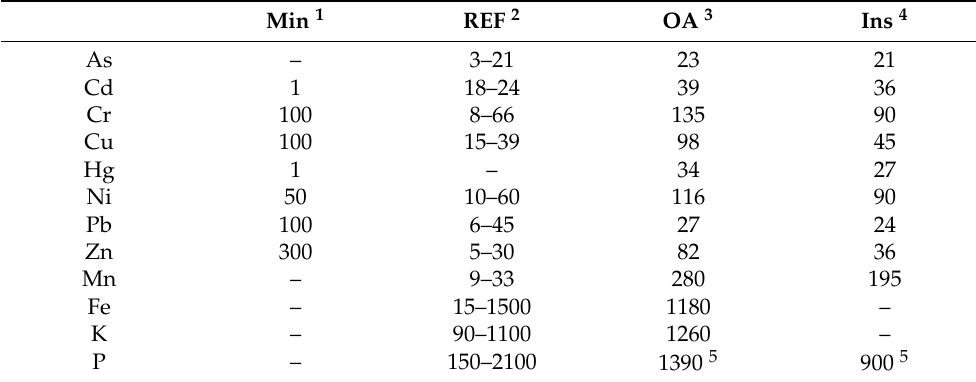
Table 3. Limits of quantification (LOQ mg kg − 1 ) of elements in organic